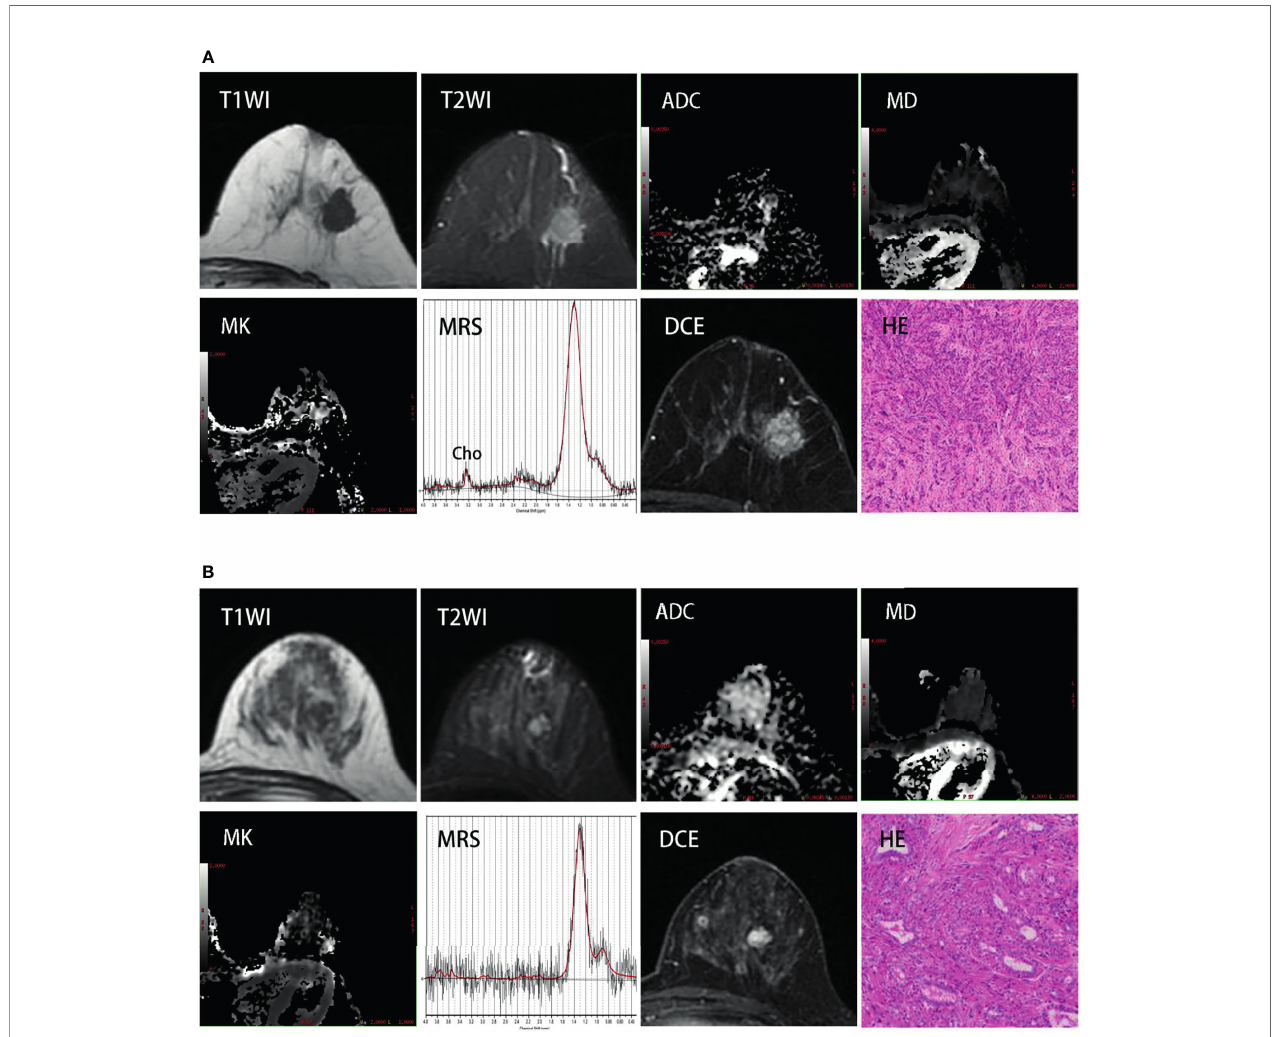
FIGURE 2 | (A) Invasive ductal breast carcinoma grade 3 (estrogen receptor-positive, 98%; progesterone receptor-positive, 98%; HER-2-negative, Ki-67-positive, 90%) in a 58 year-old woman. Images show an unregular lesion of decreased T1 signal and increased T2 signal in the left breast. DCE-MRI shows a mass with unregular borders and imhomogenous enhancement. MK map shows increased signal intensity in this region compared with surrounding glandular (mean:1.867); MD map and ADC map both show decreased signal intensity in the same region (mean:0.919×10 -3 mm 2 /sec and 0.635×10 -3 mm 2 /sec); 1 H-MRS shows a noticeable Cho peak at 3.23 ppm. (B) Fibroadenoma in a 35-year-old woman. There is an oval lesion with decreased T1 signal, increased T2 signal, regular borders and homogenous enhancement in the left breast. MK map, MD map and ADC map show non-different signal intensity in this region compared with surrounding glandular (mean: 0.243, 1.93×10 -3 mm 2 /sec and 1.613×10 -3 mm 2 /sec); Cho peak doesn ’ t appear at 3.23 ppm in 1